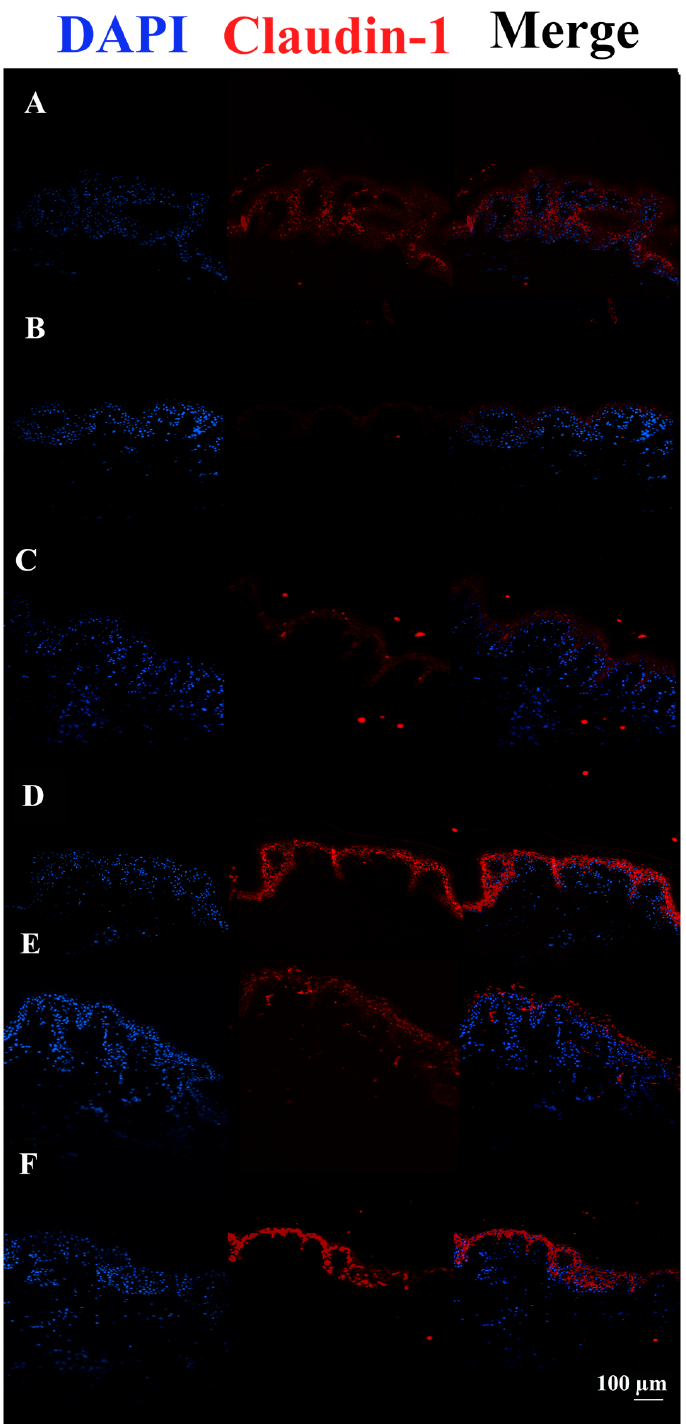
Figure 6. Claudin-1 immunofluorescence on animal explant sections infected with S. aureus DSM20491 live bacteria (20× magnification). DAPI channel (461 nm, blue) is shown on the left side; Anti-Claudin-1 antibody Alexa568-conjugated is in the middle; merge images are shown on the right. Lane description. ( A ) Not infected tissues; ( B ) not treated infected tissues; ( C ) c40 pre-incubated infected tissues; ( D ) Hac40 pre-incubated infected tissues; ( E ) c40 co-incubated infected tissues; ( F ) HAc40 co-incubated infected tissues. Tissues pretreated with c40 and HAc40 or co-incubated with HAc40 showed Claudin-1 up-regulation compared to untreated tissues. Scale bar 100 µm.